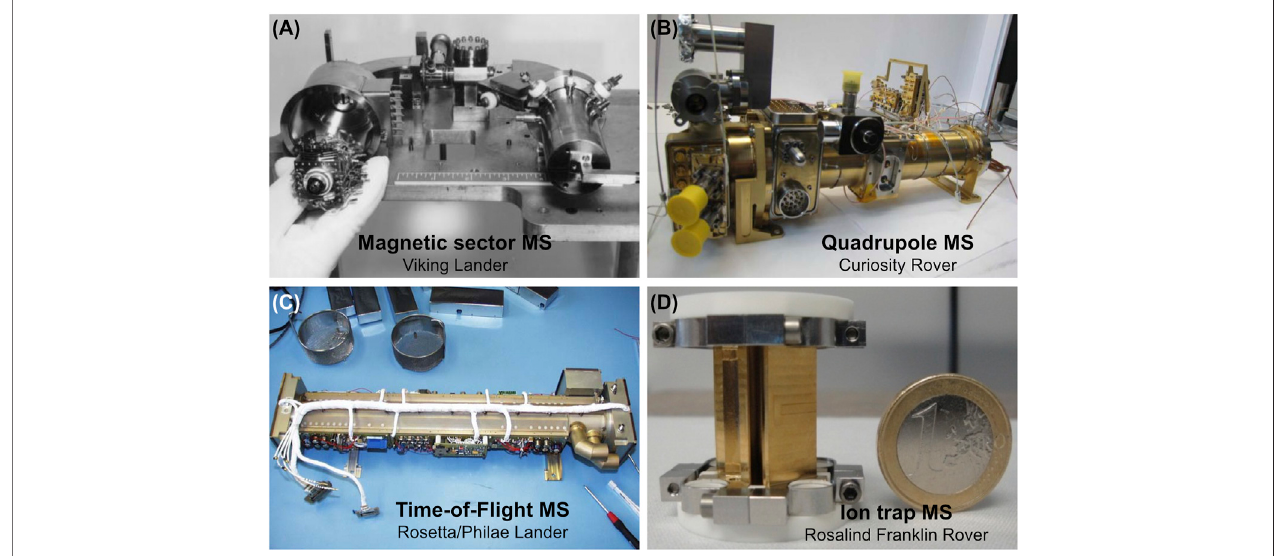
FIGURE 1 | A variety of miniaturized mass analyzers that have been fl own and will fl y on planetary missions. (A) A magnetic sector MS was carried on the Viking landers. (B) Aquadrupole MSwascarried onboardtheCuriosityrover. (C) Atime-of- fl ightMSwas fl ownontheRosetta/Philae lander(aspart oftheCOSACinstrument suite). (D) An iontrap MS aspart ofthe MOMA instrumentsuitewillbe fl own onboard the Rosalind Franklin rover. Reprinted with permission from Levin et al.(2000) and from Dr. Fred